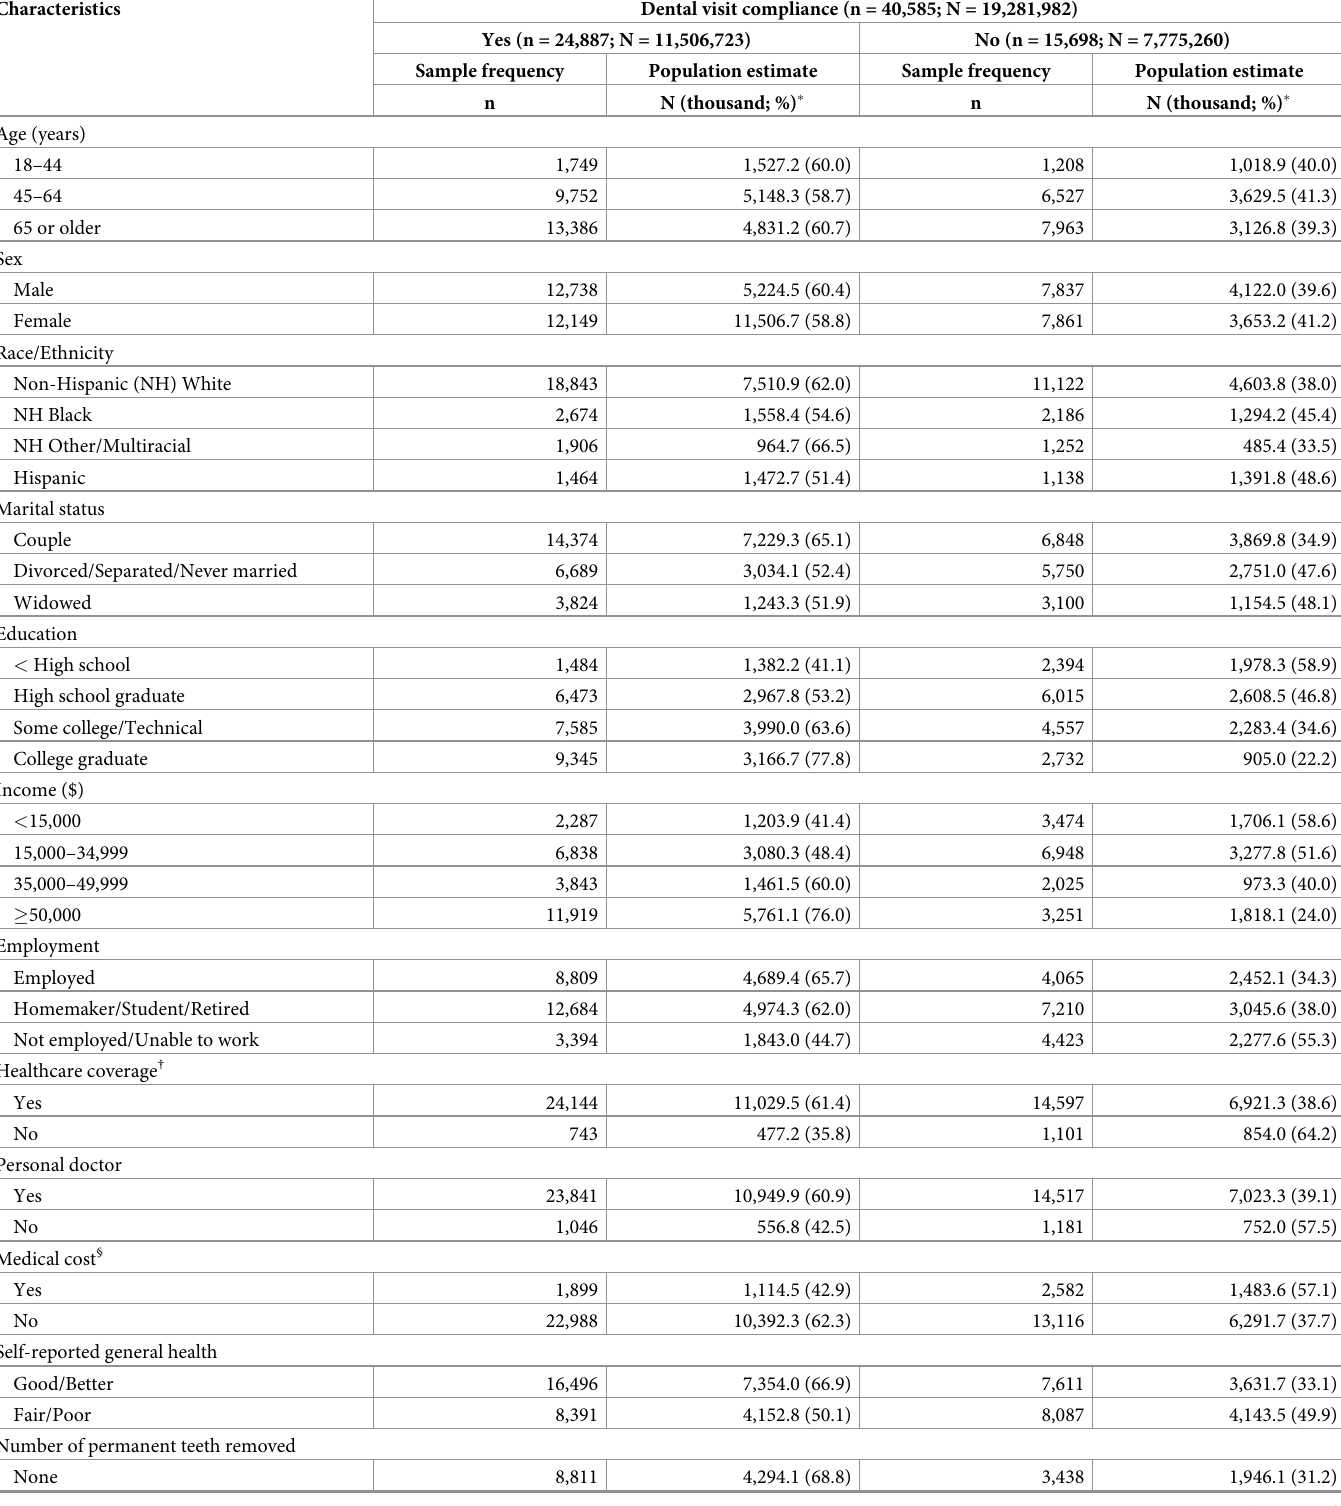
Table 1. Dental visit compliance by participants’ characteristics.